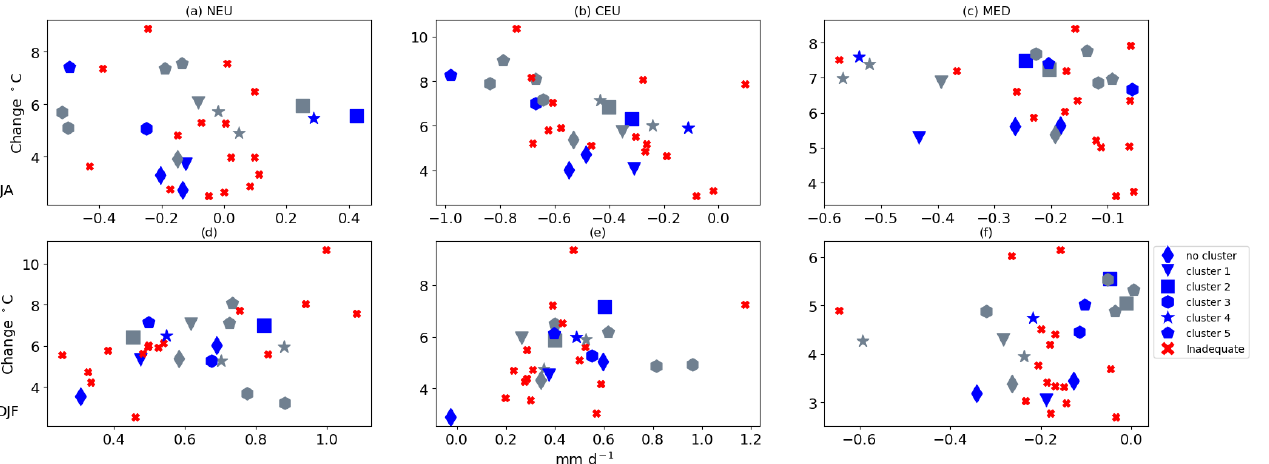
Figure 8. Temperature and precipitation projection range (SSP585; 2018–2100 relative to 1995–2014) for CMIP6 multi-model ensemble. Excluded models are shown in red. Models selected from each of the seven clusters in Table 1 are shown in blue. Models from the process- performance-filtered subset that were not selected are shown in grey. Models from the same cluster are indicated by symbols.